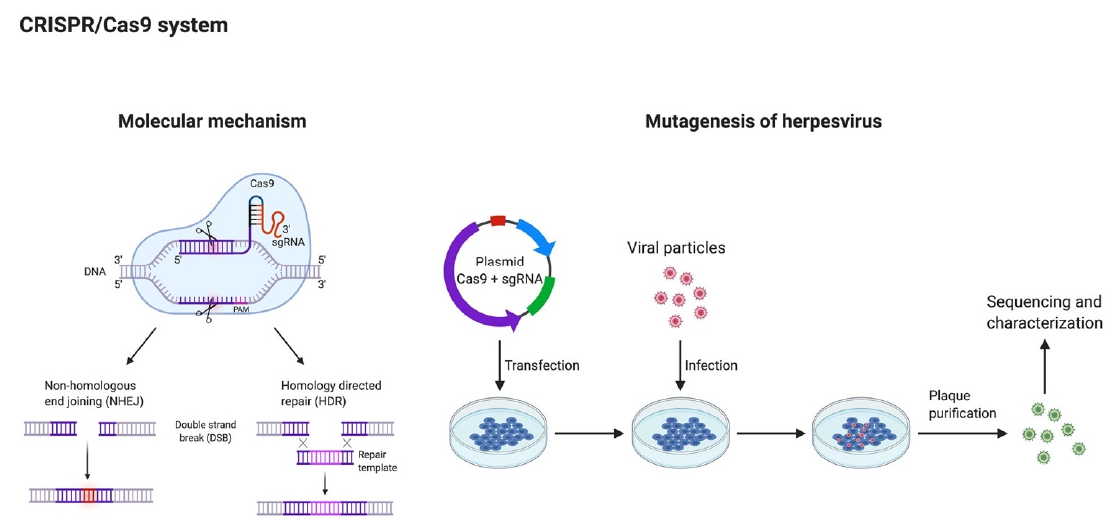
Figure 5. CRISPR/Cas9 system and its application to herpesvirus mutagenesis.